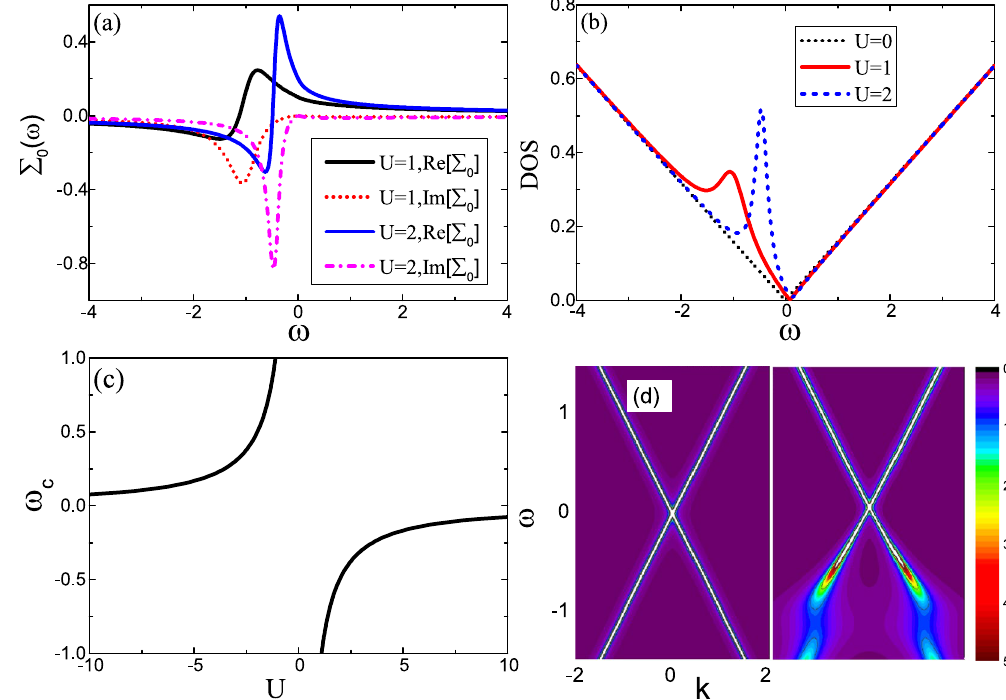
Figure 1. Evolution of ( a ) real and imaginary parties of impurity self-energies ∑ 0 ( ω ) and of ( b ) DOS with impurity potential U , where a resonant state is developed remarkably. ( c ) The position of DOS resonant peak as a function of U . ( d ) The electron spectrum function A ( k , ω ) as functions of k and ω for U = 0 (left side) and U = 1 (right side). The other parameters